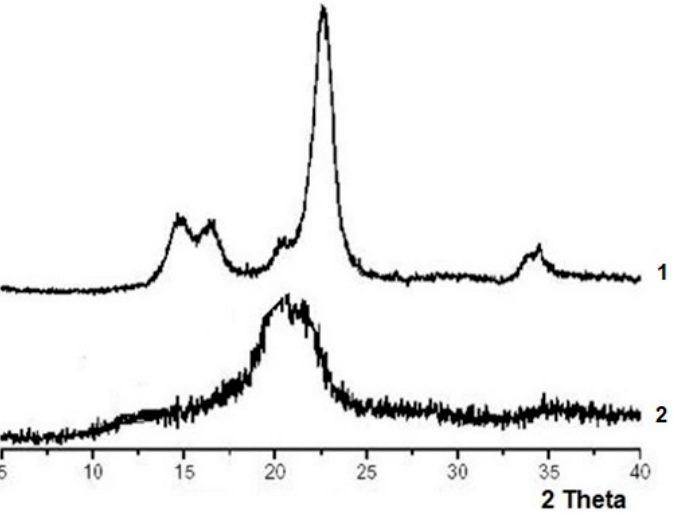
Figure 2. X-ray patterns of MCC (1) and VF (2).